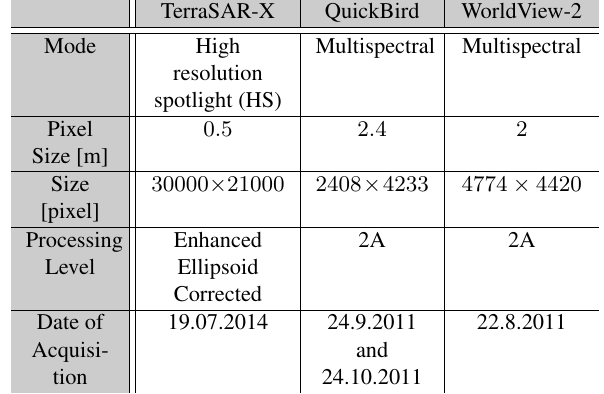
Table 1: Details of TerraSAR-X, QuickBird and WorldView- 2